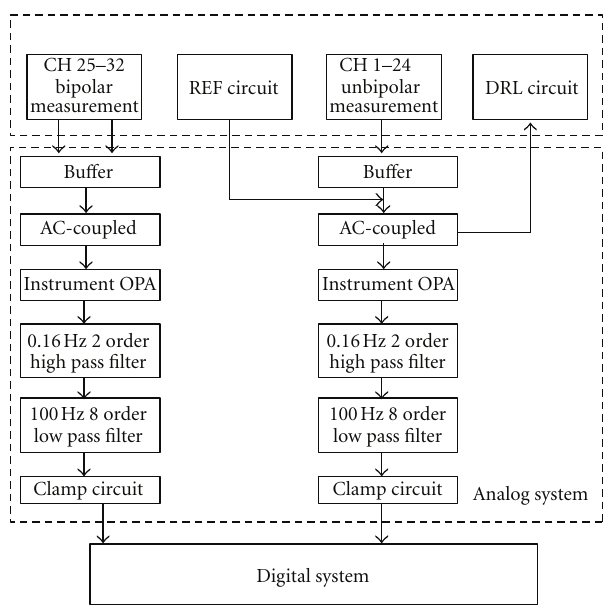
Figure 2: Hardware